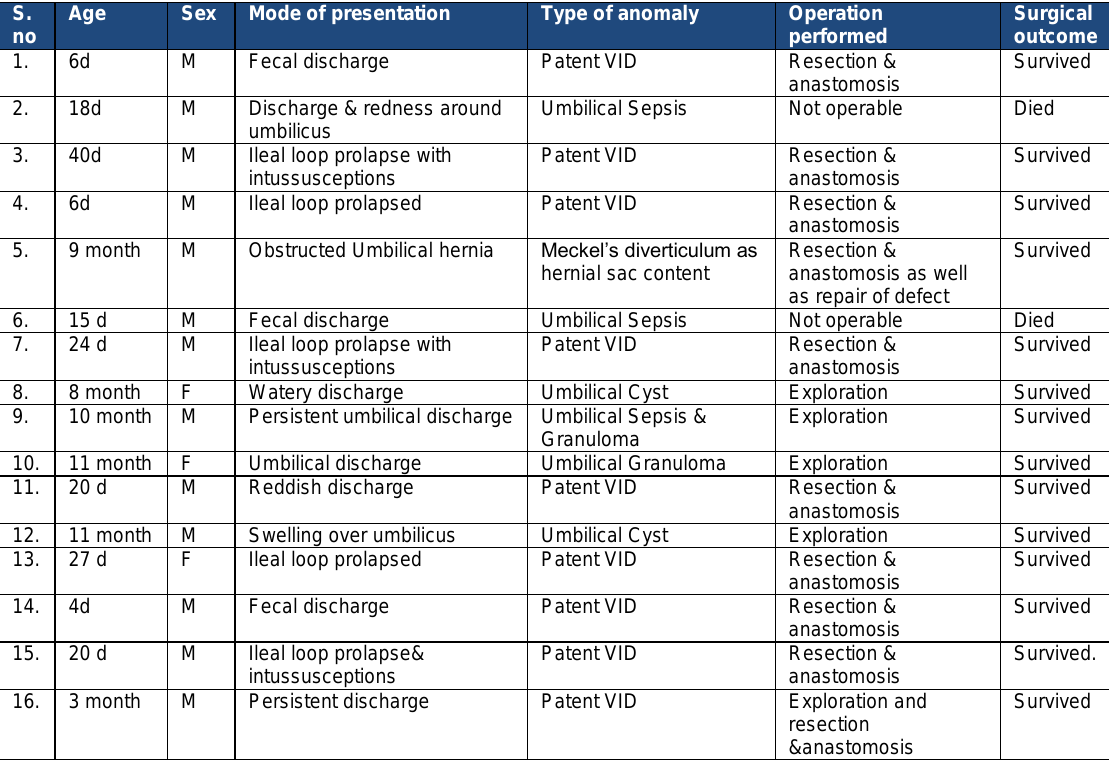
Table 1: Summary of presentation, type of anomaly, operation performed and